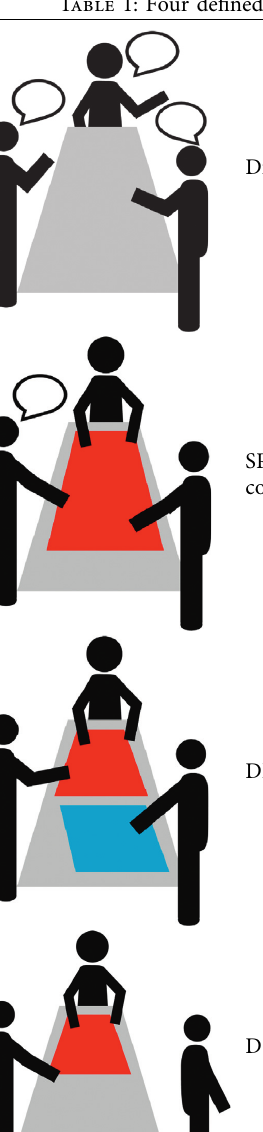
Table 1: Four defined collaboration categories indicating different approaches of participants when working together.